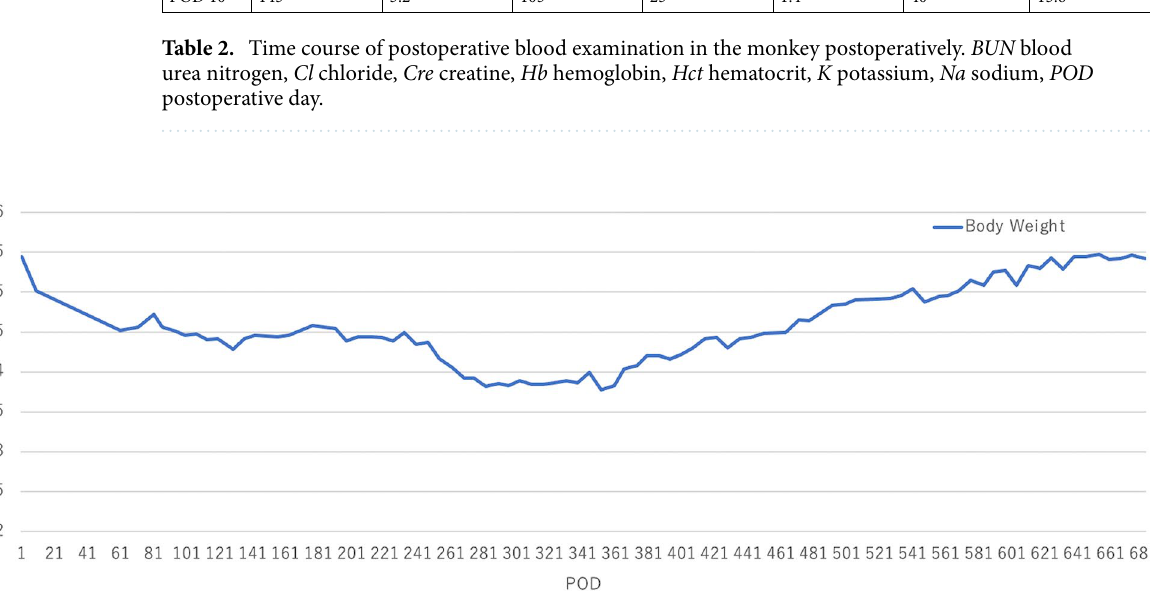
Figure 5. Time course of postoperative body weight in the